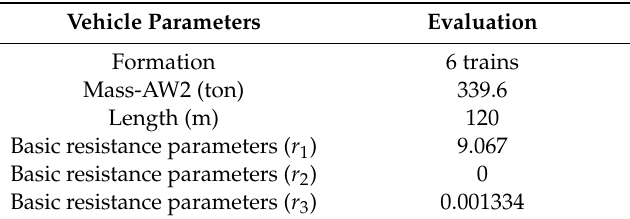
Table 3. Vehicle data.